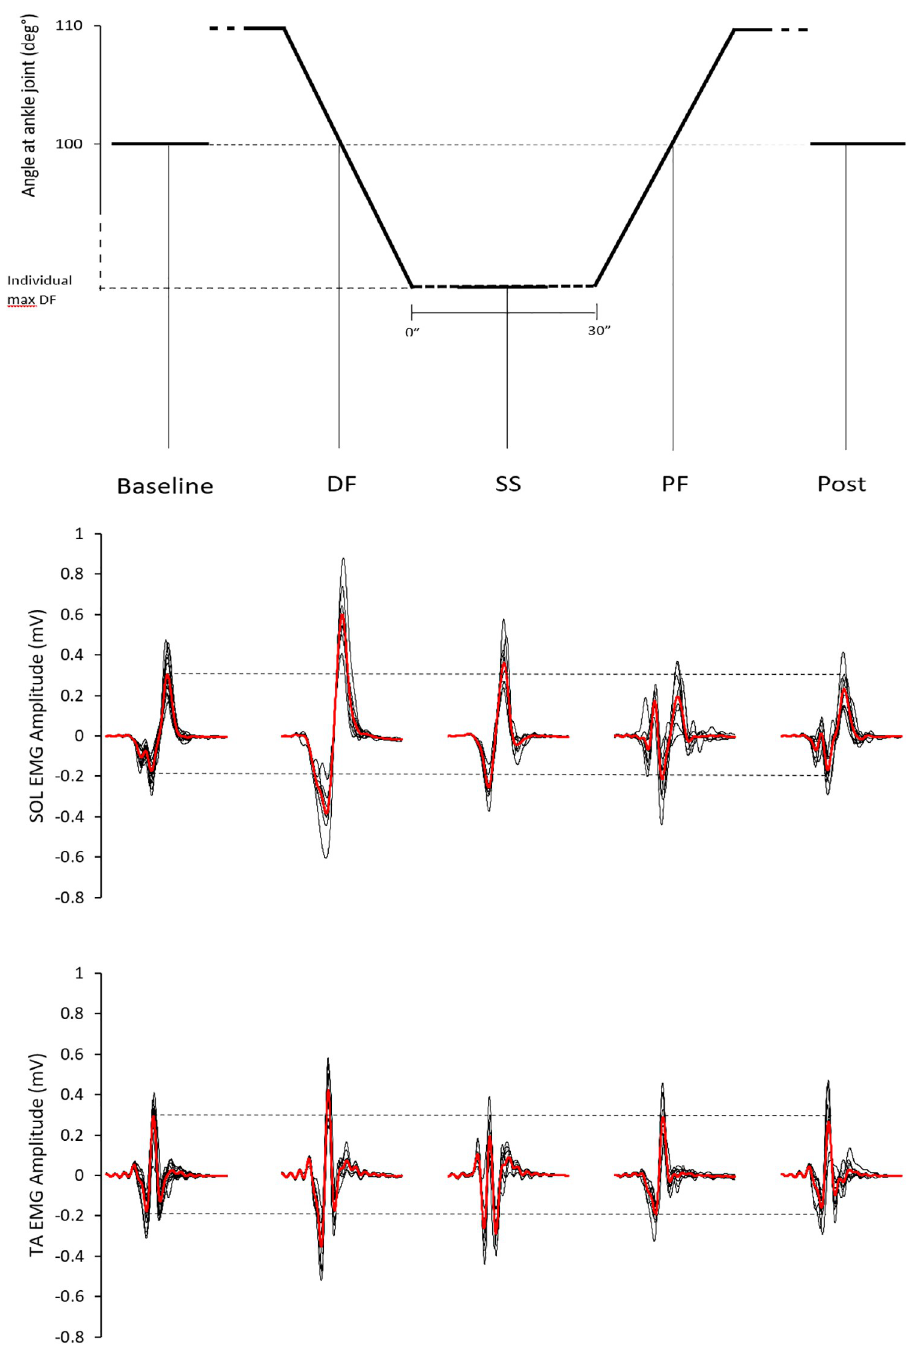
Fig 3. Single subject example for MEPs. On the upper part of the graph is outlined the angle at the ankle joint at which the stimulations were delivered. In the middle and lower part of the graph are presented the SOL and TA EMG tracks recorded at: Baseline, during DF, during SS, during PF and after stretching. For baseline circa 15 waves are superimposed (black waves), for all the other stimulation points circa 10 waves are superimposed. The thicker red waves represent the average values and the dashed horizontal lines limit the positive and negative peak of the average baseline value. For graphical purposes raw data was down sampled and low passed filtered.